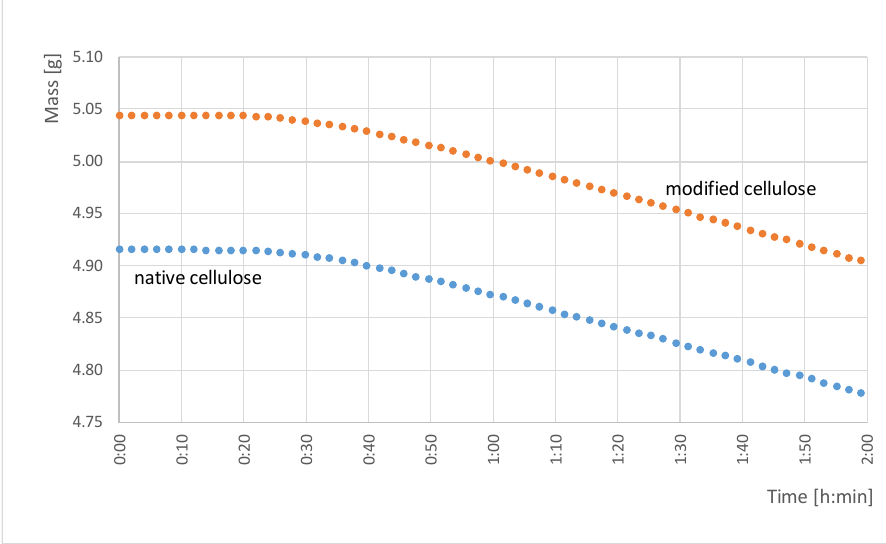
Figure 3. The course of mass measurement in the process of water vapor permeability determination for the examples of native and modified cellulose .